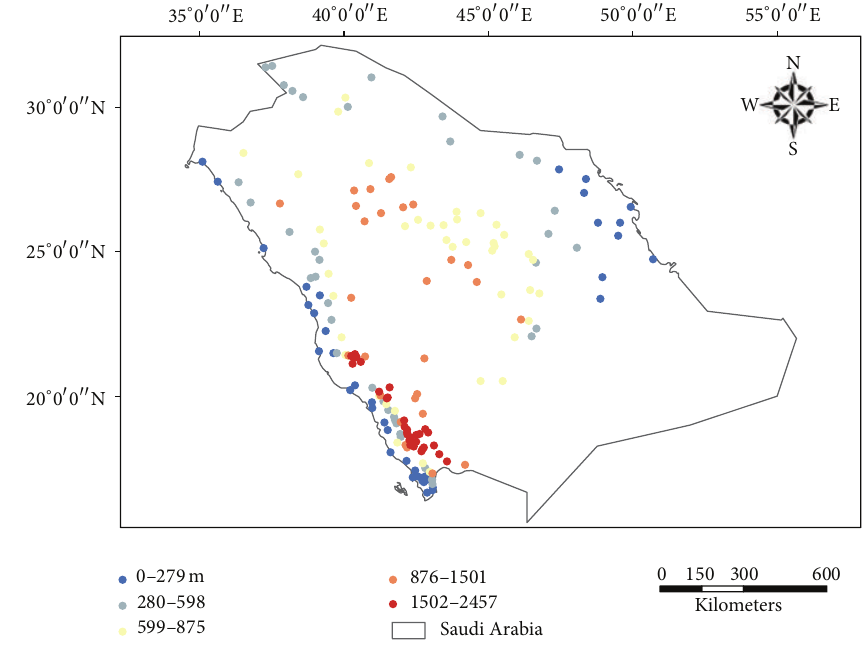
Figure 3: Rainfall stations with corresponding